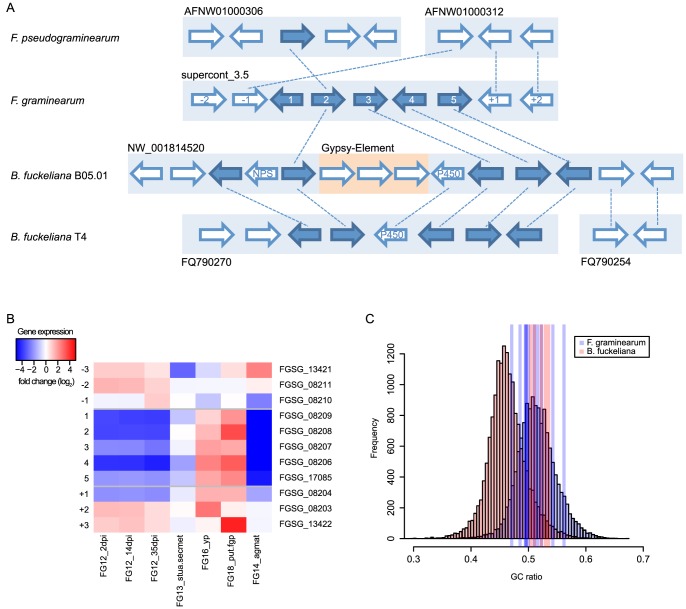
Evidence of horizontal gene transfer and regulation of predicted C47 cluster.(A) Predicted gene cluster in Fusarium graminearum and orthologous genes in F. pseudograminearum and the Botrytis fuckeliana strains B05.01 and T4 (solid dark blue arrows) on their respective supercontigs (light blue boxes). Adjacent genes are illustrated as white arrows, dashed lines depict orthologous groups. The gypsy transposable element in B. fuckeliana B05.01 is indicated as orange box. Enumeration in F. graminearum is according to Table 5. (B) The heatmap illustrates fold changes in gene expression (log2 scale) between two experimental conditions. Genes are listed in chromosomal order on y-axis. Abbreviations of experimental conditions on x-axis are according to Table 6. Horizontal grey bars show boundaries of predicted clusters. (C) Histograms show whole genome distributions of open reading frame GC ratios in F. graminearum (blue) and B. fuckeliana B05.01 (red). Vertical lines illustrate GC ratios of cluster genes.